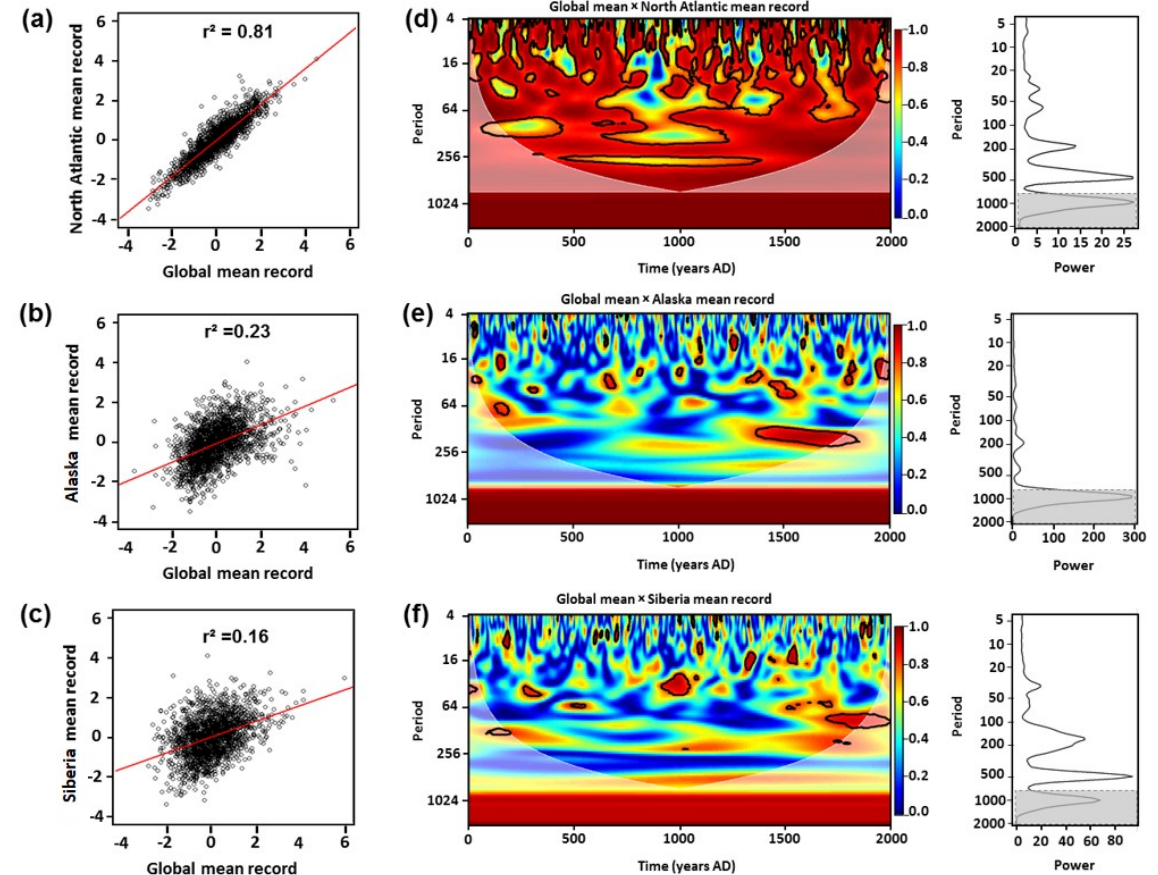
Figure 4. Left panels: correlation between the global mean based on proxy data and the three regional mean records for the (a) North Atlantic, (b) Alaskan and (c) Siberian areas. Correlations are significant at the 95% confidence level. Right panels: (e) wavelet coherence between global and North Atlantic mean records, (f) global and Alaskan mean records, and (g) global and Siberian mean records. Colors represent the amplitude of the signal at a given time and spectral period (red equals the highest power, blue the lowest). The white line corresponds to a cone of influence on the wavelet coherence spectrum. A confidence level of 95% ( α = 0.05) is indicated on the wavelet spectrum with the black